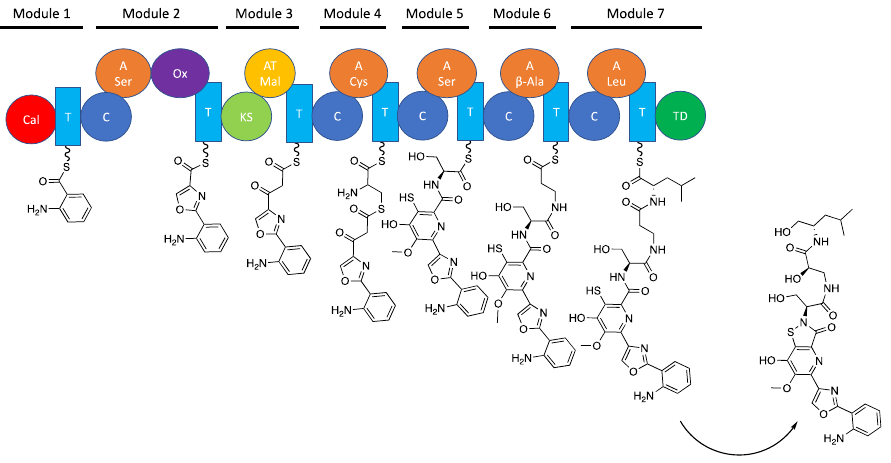
Figure 1. Proposed biosynthetic pathway for the levesquamides.